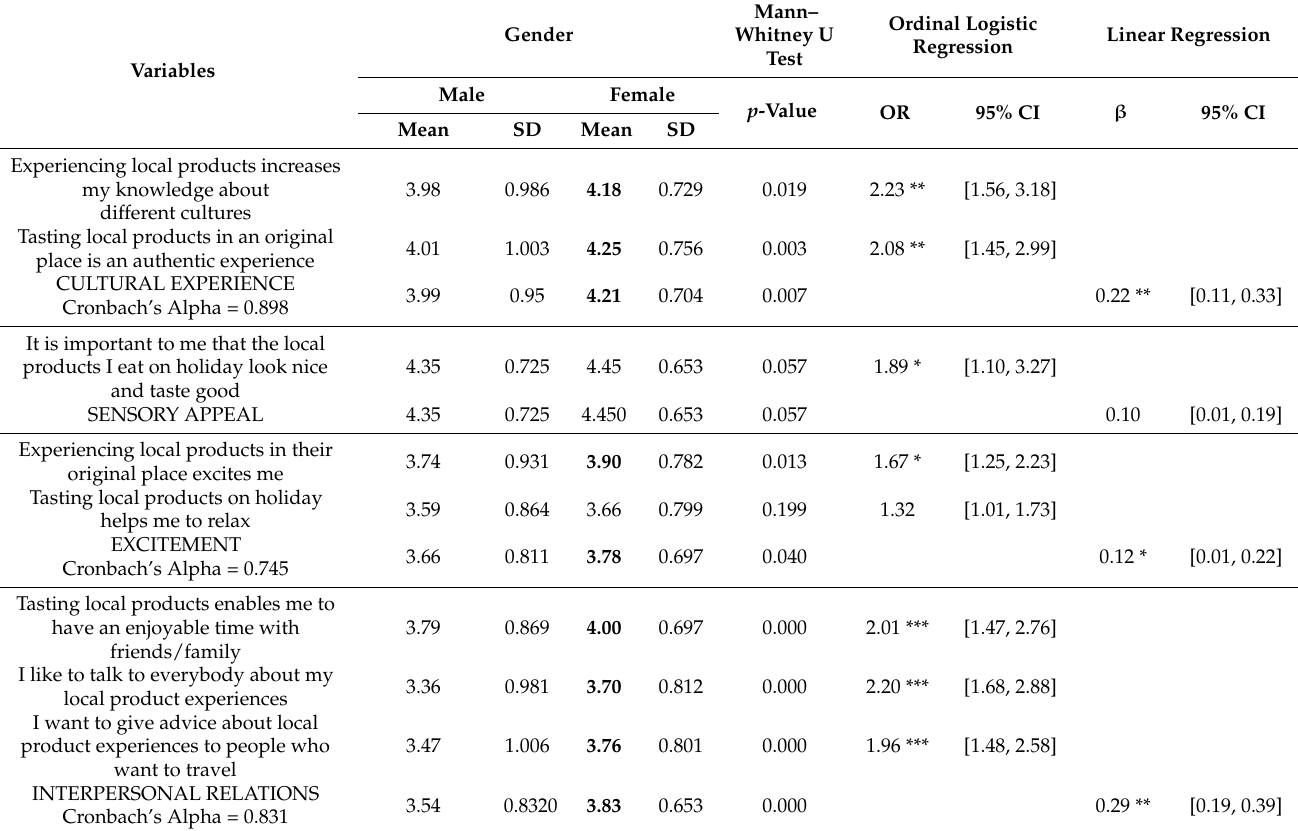
Table 6. Men and women’s motivations to consume local food during